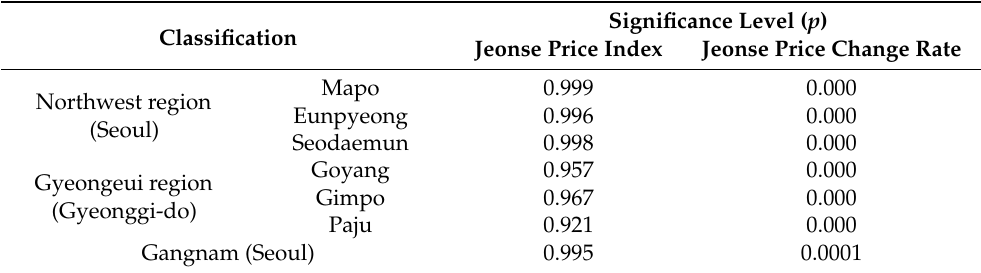
Table 1. ADF test result of jeonse